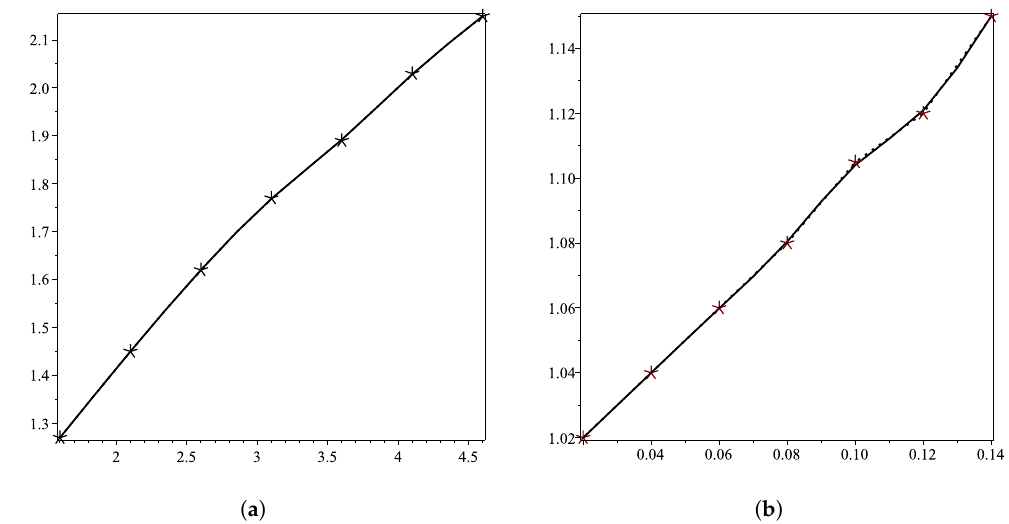
Figure 1. ( a , b ) show positive curves generated by FP -scheme (1) using positive initial data.